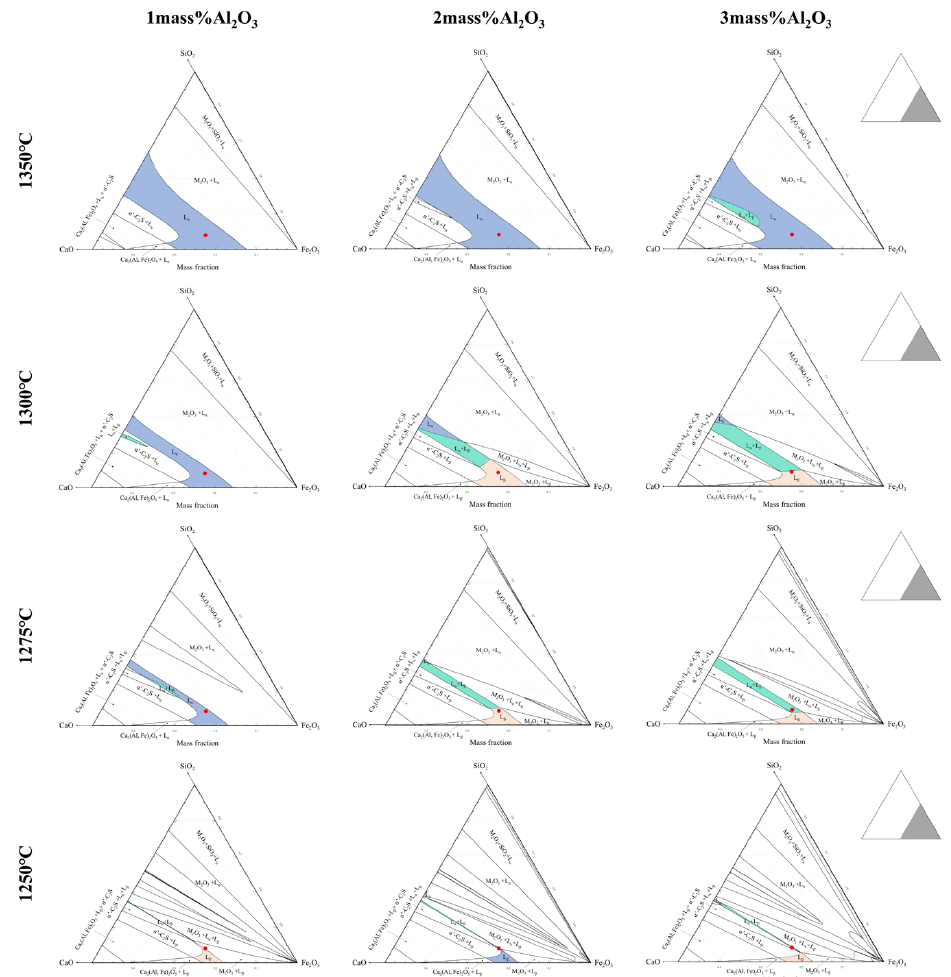
Figure 16. Isothermal cross-section of Fe 2 O 3 -CaO-SiO 2 -Al 2 O 3 system at different temperatures.